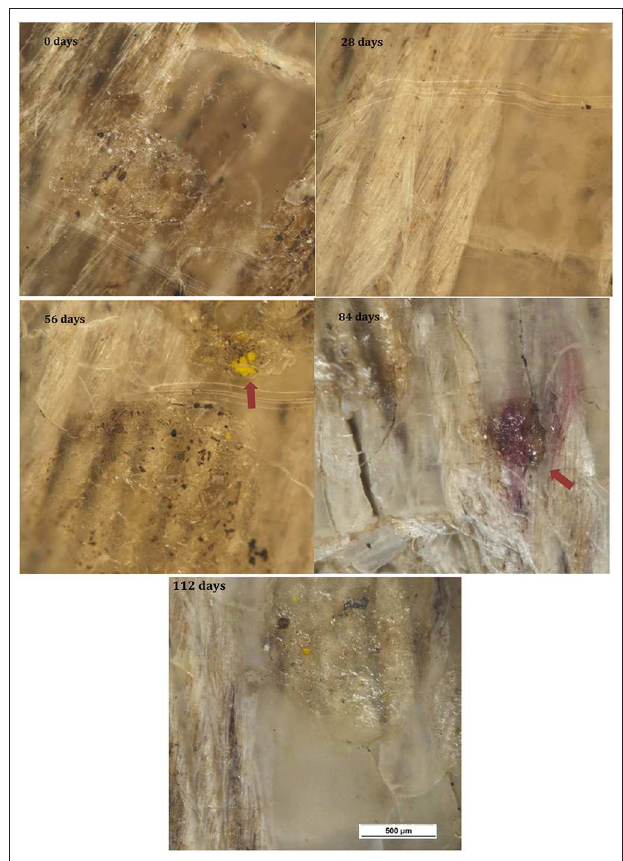
FIGURE 8 | Optical micrographs of PHBV/ENR/flax at 0, 28, 84, and 112